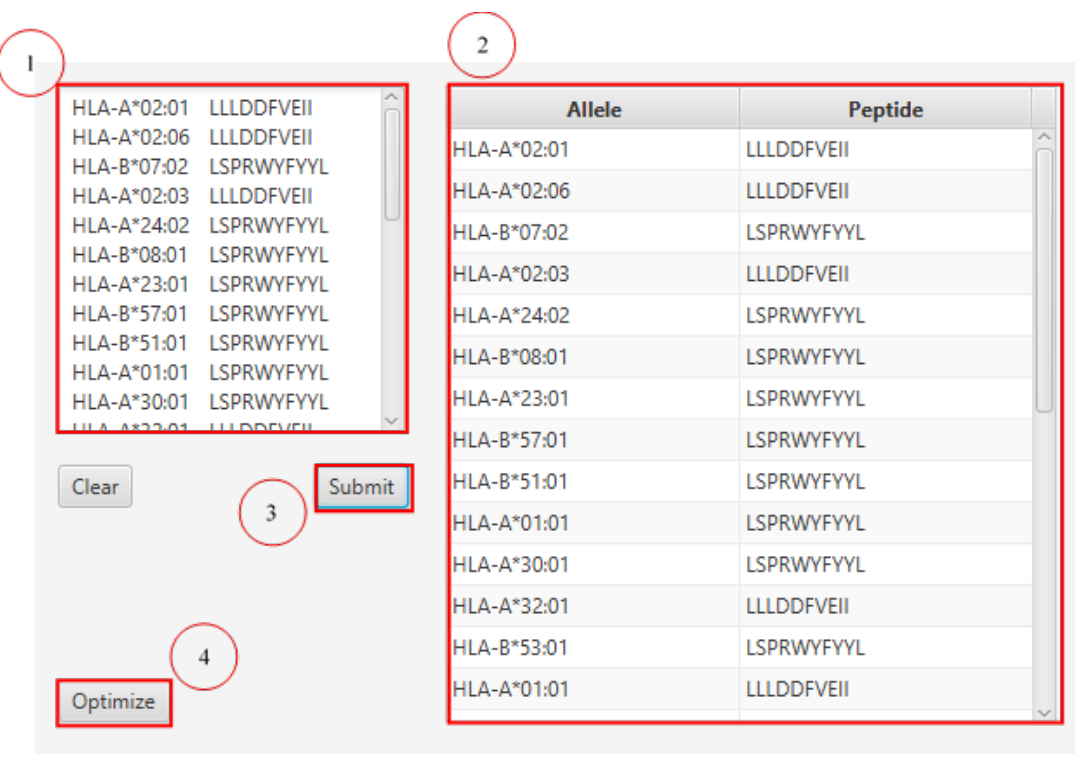
Figure 4. Home screen of PopCoverageOptimization (PCOptim) graphical user interface (GUI) system. Raw epitope data can be inputted in the left-most textbox. After submitting the input, the data will appear formatted in the right-most table. Clicking the “ Optimize ” button will display the optimized data.